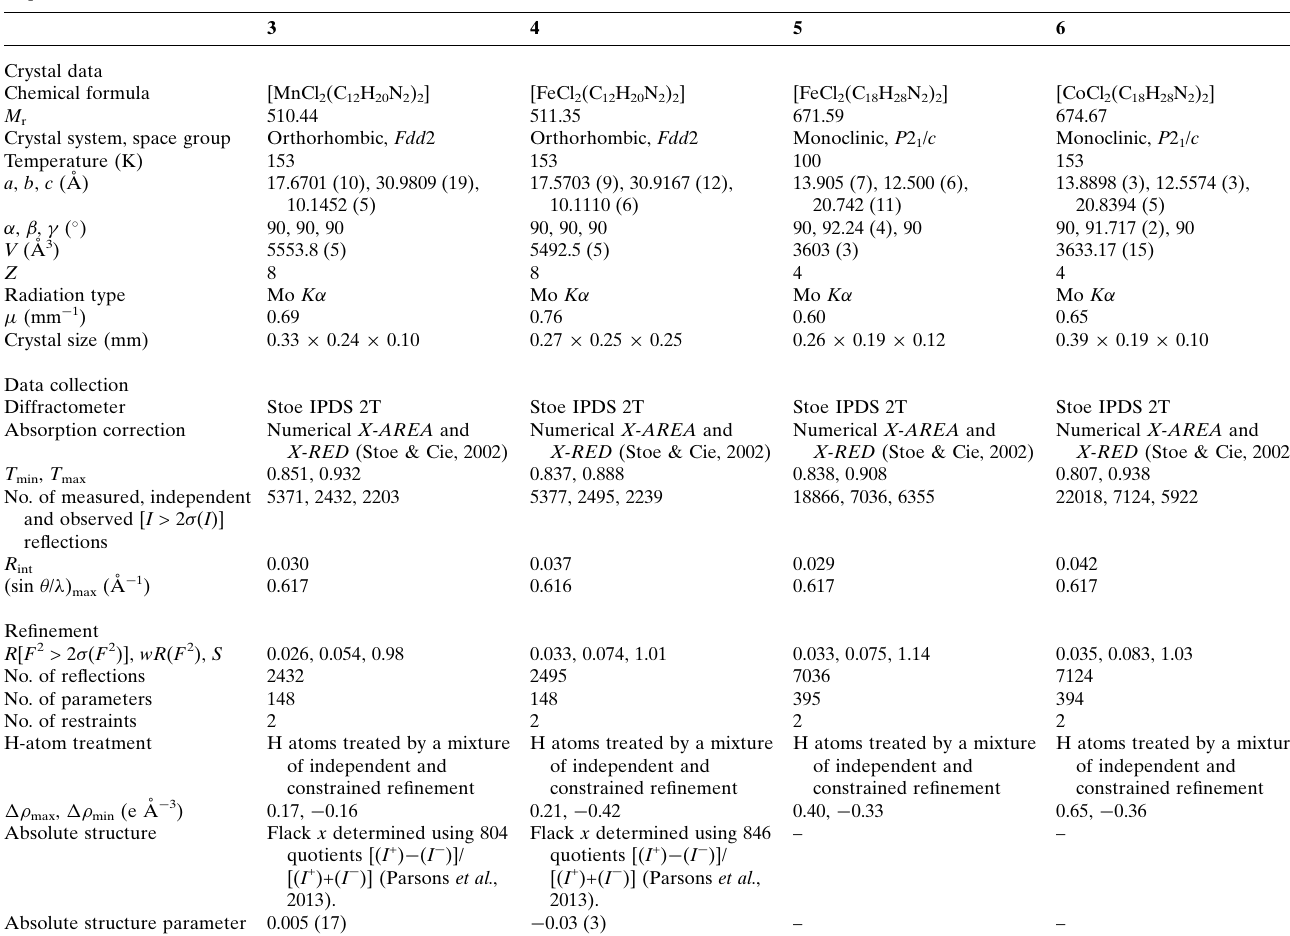
Table 5 Experimental details.